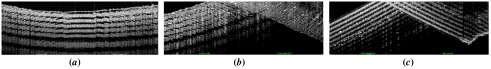
(a) On-axis image of Target B where all the layers are distinguishable (b) WPE rotated by 20∘, equivalent to six rings in Target A shown in Figure 7, only 120μm layers remain distinguishable and a mirror artefact begins to obscure the image. (c) Off-axis cylindrical scotch-tape target with similar field angle used for (b). (The colour version of this figure is included in the online version of the journal.)